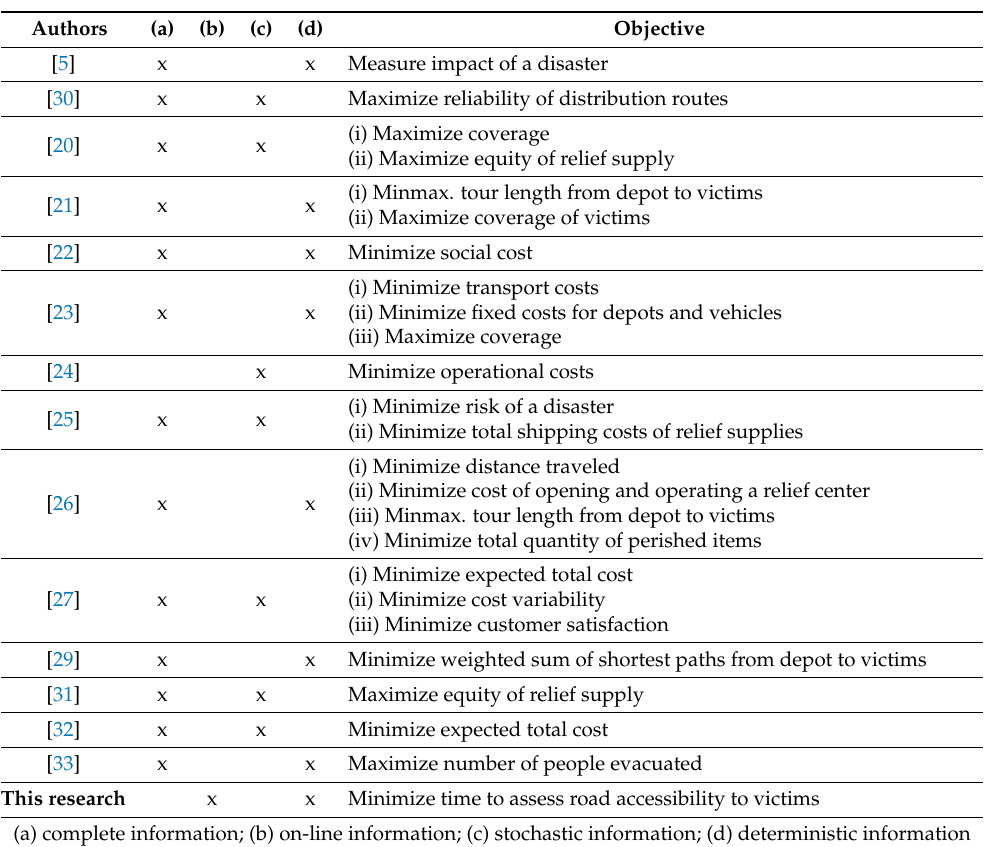
Table 1. Summary of the literature related to humanitarian operations and disrupted road networks.